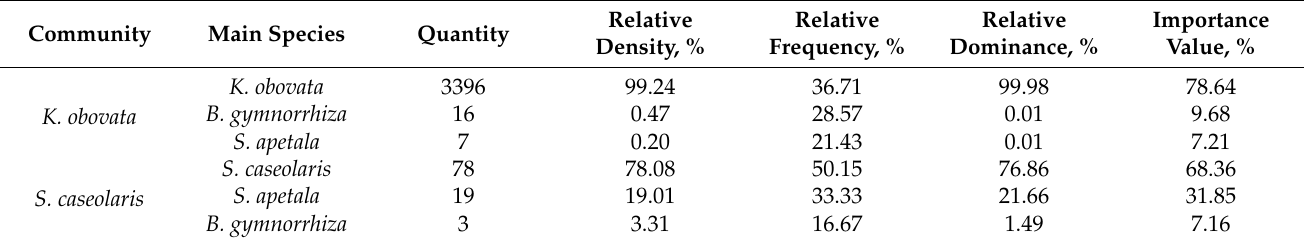
Table 2. Importance values of the arbor layer in the K. obovata and S. caseolaris communities on the west coast of Bao’an, Shenzhen.